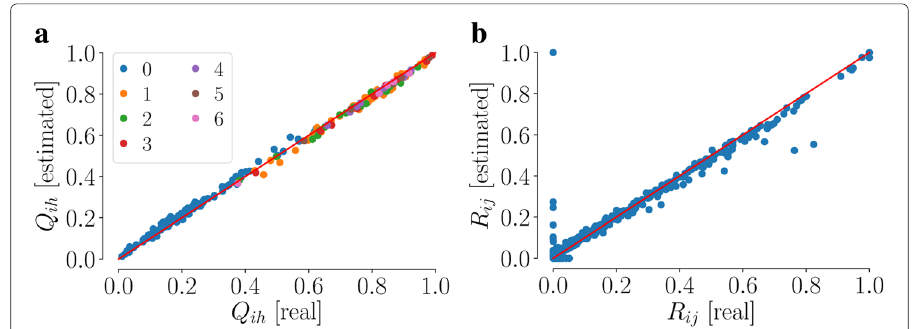
Fig. 6 Validation on the synthetic benchmark with exclusive communities. Estimation of the nonzero entries of ( a ) the community matrix Q and ( b ) the backbone matrix R for the benchmark with exclusive communities, from data sampled over a time-window of duration T = 10 6 . The parameters are set as γ i = ¯ γ i , ∀ i ∈ V . Different colors in ( a ) refer to the different